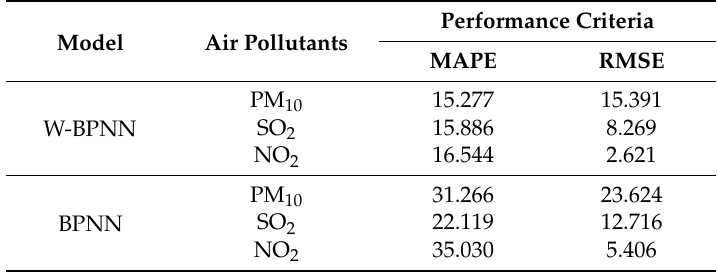
Table 10. Comparison of the forecasting performances using different